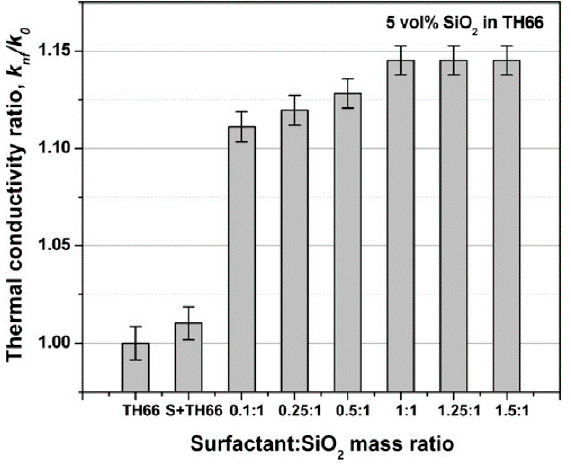
Figure 6. Enhancements in thermal conductivity of 5 vol% SiO 2 /TH66 suspensions at various surfactant ‐ to ‐ nanoparticle (SN) ratios. S + TH66 indicates the thermal conductivity measured in a base fluid with the highest surfactant concentration used in the series (i.e., a 1.5:1 ratio) [56].